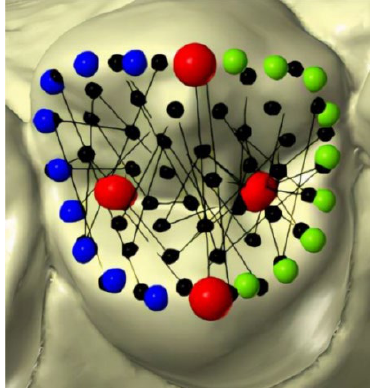
Figure 1. Distribution of landmarks (red points) and semilandmarks (blue, green, and black points) on the premolar occlusal surface.